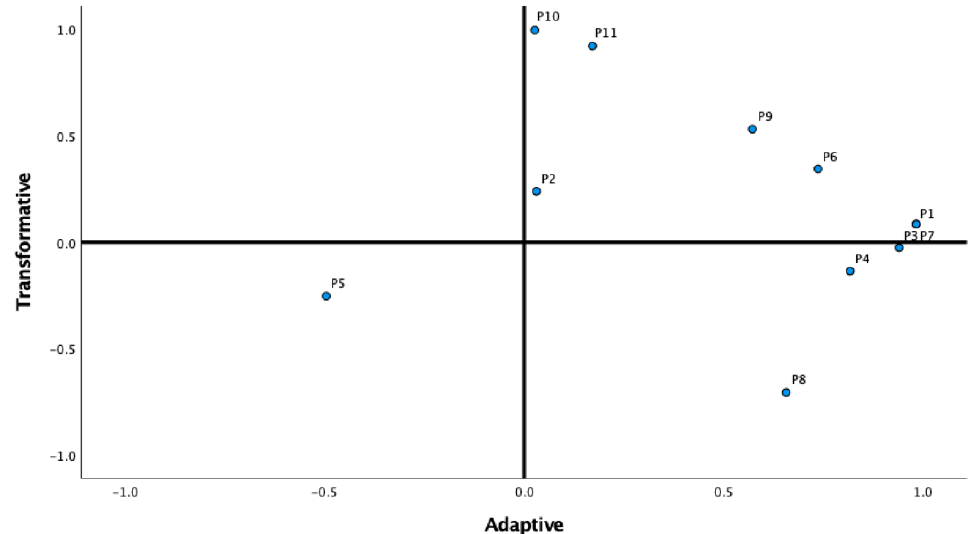
Figure 2. Principal component analysis of approaches to heat decarbonisation.